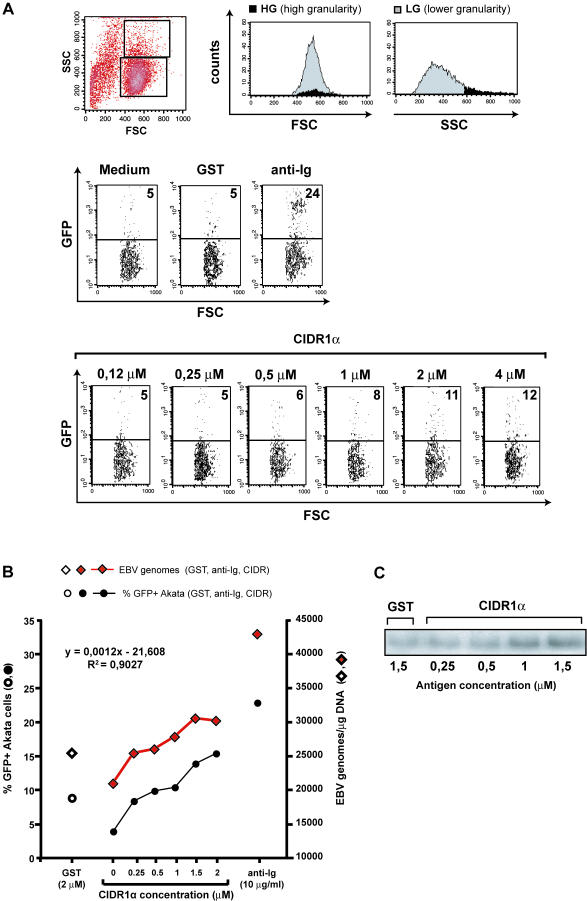
Induction of EBV Lytic Cycle in Akata-GFP Cells upon Stimulation with CIDR1α(A) Akata-GFP cells were cultured in medium alone, with GST (4 μM), with CIDR1α (0,12–4 μM), or with anti-Ig (10 μg/mL). After 48 h of incubation, a FACS analysis was performed. Cell populations were divided into cells with low granularity (LG) and cells with high granularity (HG) on the basis of side scatter (SSC). The proportion of cells in lytic cycle (GFP-positive) was then quantified in the HG subpopulation. The figure shows one representative experiment. FSC, forward scatter.(B) Akata-GFP cells were cultured with GST (2 μM), with CIDR1α (0–2 μM), and with anti-Ig (10 μg/mL). After 48 h of incubation, the proportion of GFP-positive cells was quantified by FACS analysis (circles), and the EBV DNA load was assessed by real-time PCR (diamonds). The left y-axis denotes the proportion of Akata-GFP–positive cells in lytic cycle, the right y-axis denotes the number of EBV genomes. Controls included GST-stimulated (empty diamonds/circles) and anti-Ig–stimulated cells (filled diamonds/circles). Data show the mean of three independent experiments.(C) Akata cells up-regulate BZLF1 upon stimulation with CIDR1α. Akata-GFP cells were cultured with GST (1,5 μM) or with CIDR1α (0,25–1,5 μM). After 48 h of incubation, the expression of BZLF1 was analyzed by Western blot. Increased BZLF1 expression in CIDR1α stimulated samples was confirmed by relative quantitative analysis with Quantity One software (Bio-Rad).